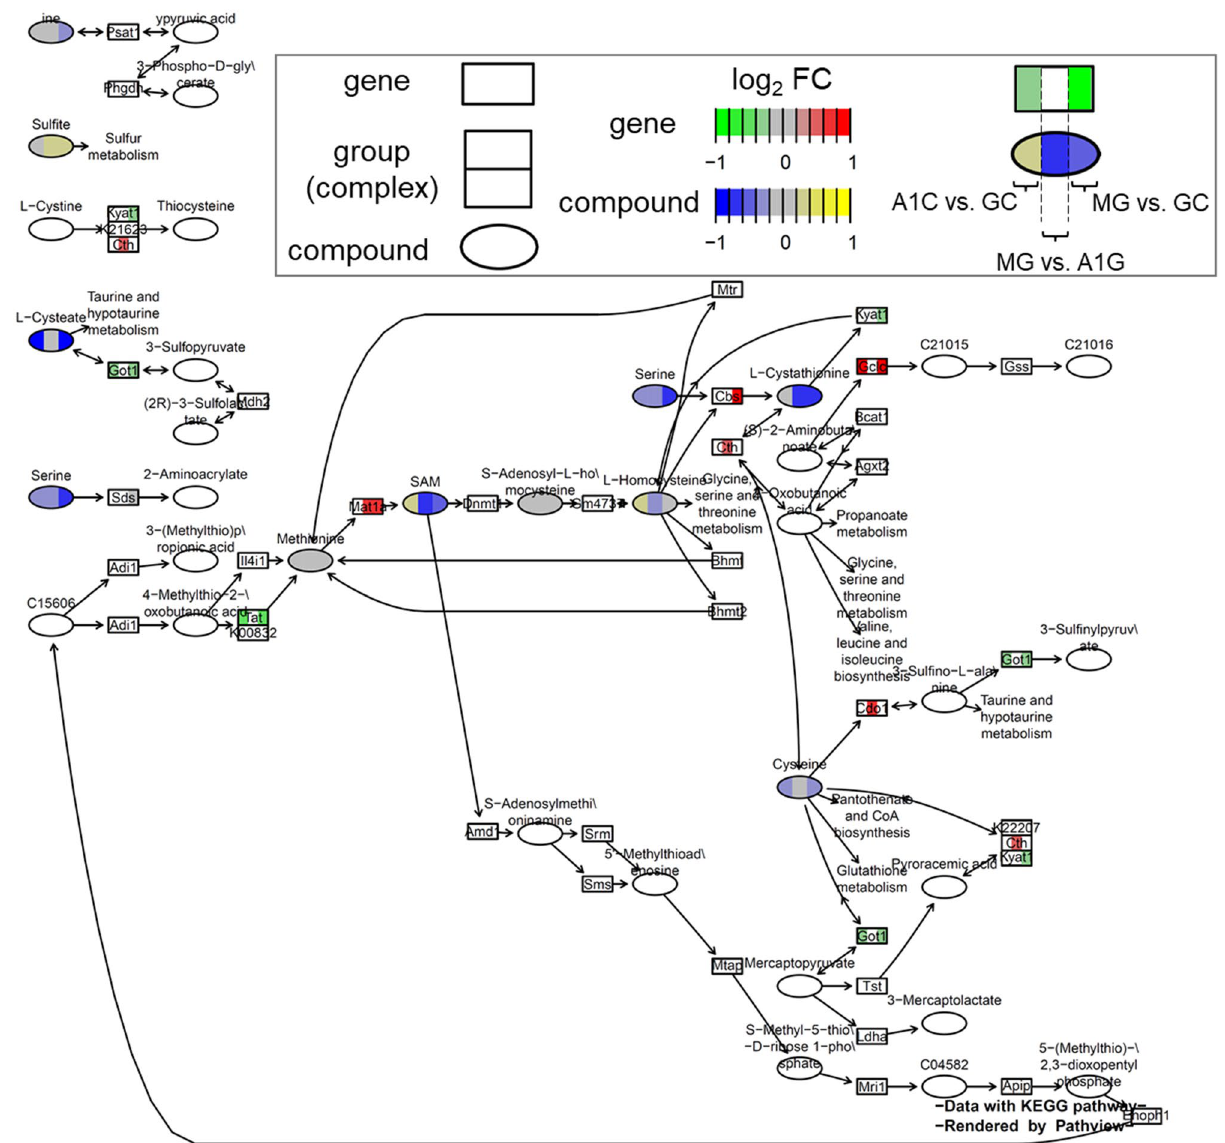
Figure 6.. Pathway-based data integration and visualization of KEGG PATHWAY 00270 “Cysteine and methionine metabolism”. Analysis was conducted in R 31 using the R package pathview 42 , which renders the metabolome and transcriptome data on the pathway. The color of genes and compounds means log 2 fold change (log 2 FC), separated by three parts containing the ratio of A1G vs. GC (left), MG vs. A1G (middle), and MG vs. GC (right). Control mice on Earth (GC), mice under artificial earth-gravity in space (A1G), and mice under microgravity in space (MG). Images were obtained by KEGG 43,44